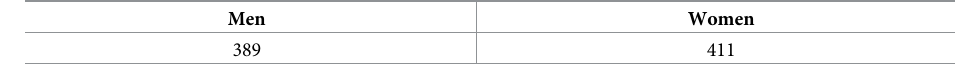
Table 1. Gender of the respondents (N =